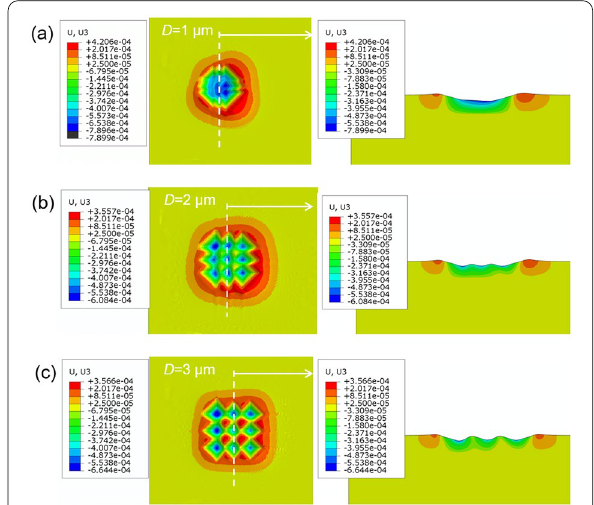
Figure 15 Top views and the corresponding cross-sections of the simulated results for the 3 3 indentation arrays with the rotation × angle of 0° and the spacings of a 1 μm, b 2 μm and c 3